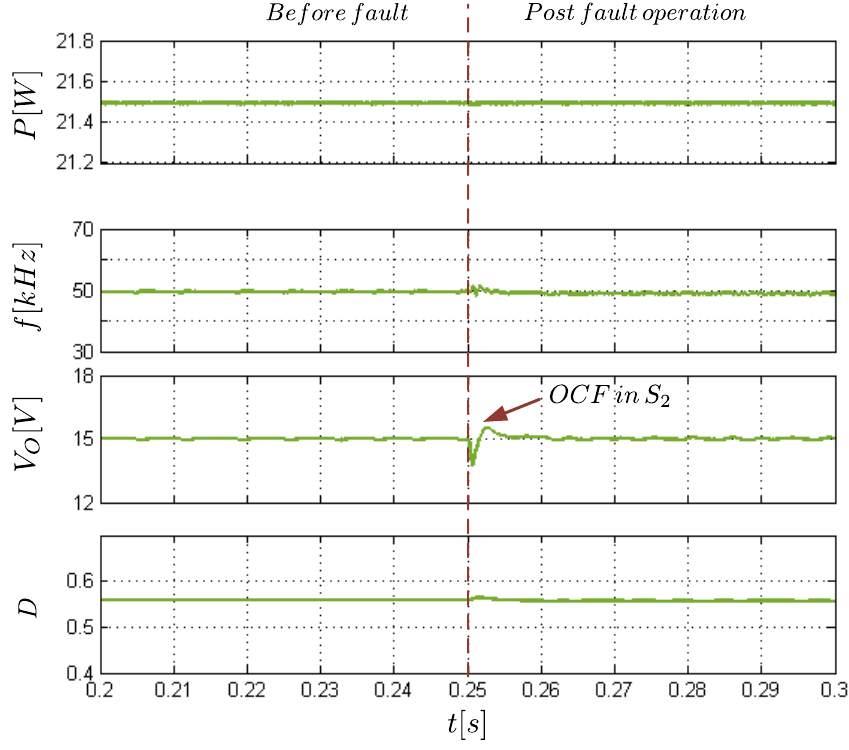
Figure 17. OCF in the switch S 2 at t = 0.25 s; from the top to the bottom P , f , V O and D